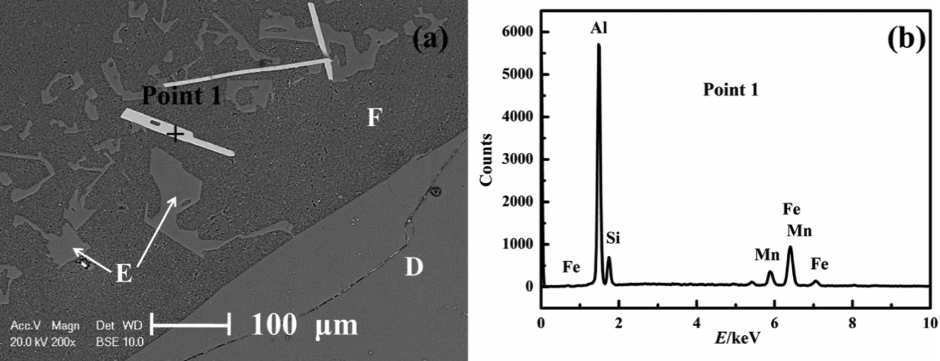
Figure 3: The SEM image of solidified sample No.2 and EDS image of Point 1 (a) SEM image of solidified sample No.2, (b) EDS image of Point 1.